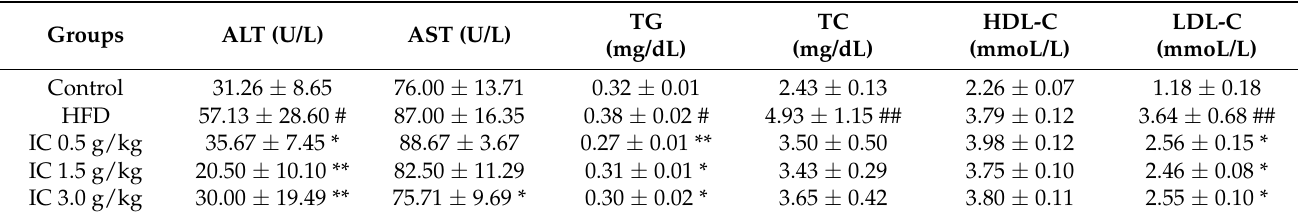
Table 1. Serum biochemical markers in each group (XS, n = 6).